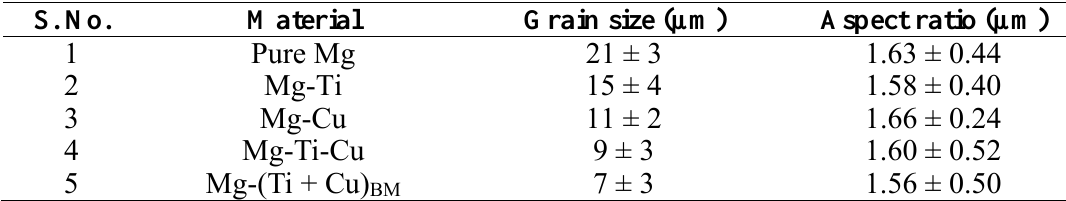
Figure 2. SEM micrographs showing the distribution of ( a ) Ti particulates in Mg-Ti composite; ( b ) Cu/Mg Cu intermetallic particulates in Mg-Cu alloy; ( c ) Ti and Cu/Mg 2